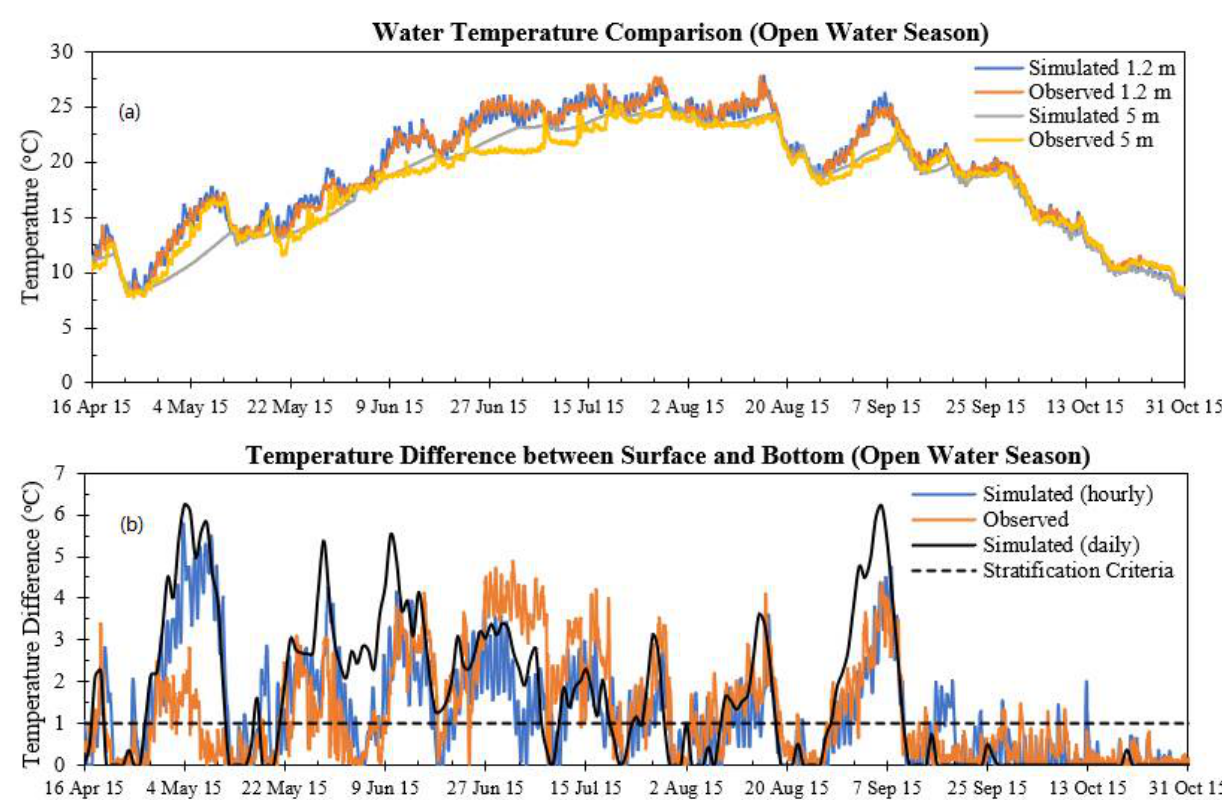
Figure 12. ( a ) Time series of observed and simulated hourly water temperature at 1.2 m and 5 m in Pearl Lake in open water season in 2015, ( b ) differences of simulated and observed hourly temperatures between 1.2 m (surface) and 5 m (near the bottom) during open water season in 2015 in Pearl Lake including simulated daily temperature differences and 1 °C difference as stratification criterion.